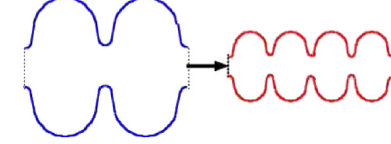
FIG. 15. (Color) Doubling of frequency and doubling of cells.